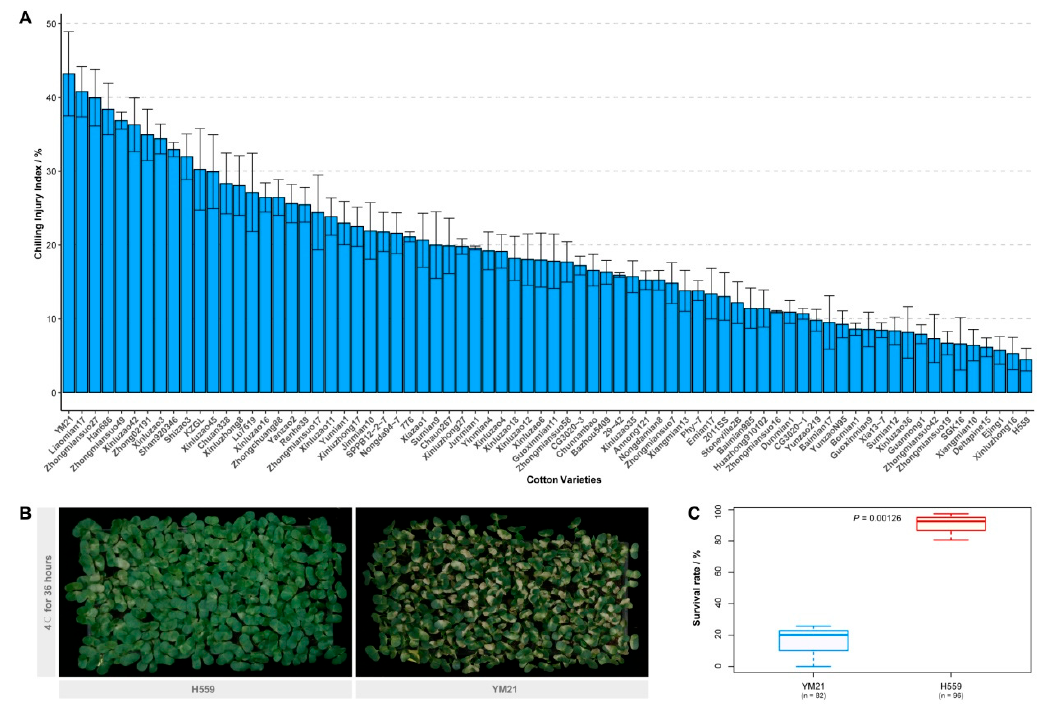
Figure 1. Assessment of seedling chilling injury (CI) index and investigation of survival rate. ( A ) Evaluation of the cotyledon CI index of 74 upland cotton varieties. The seedlings growing to the seventh day were treated with cold stress (4 °C) for 36 h and then recovered for another week, after which the chilling phenotype was investigated. Error bar indicates the standard error (SE) of the mean ( n = 3). ( B ) Chilling injury symptoms of H559 and YM21 seedlings recovered one week after 4 °C stress. ( C ) The seedling survival rate of H559 and YM21 after 48 h of chilling stress.